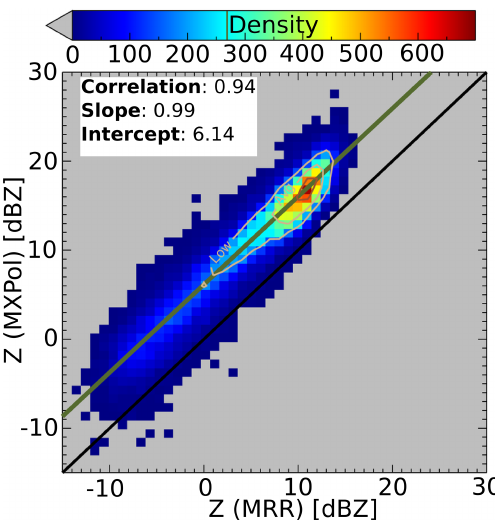
Figure 4. Scatter plot of reflectivity values at 9.41GHz (X-band, measured by MXPol) and at 24.3GHz (K-band, measured by the MRR) during the summer campaign 2015/2016. The data corre- spond to time steps at which both radar were profiling (PPI and RHI scans of MXPol do not contribute). Table 2. Parameters of the six X-band conversion relations between radar reflectivity Z and snowfall intensity S (mmh − 1 ] of Matrosov et al., 2009, and the local relation, obtained using the instruments at DDU. In these relations, the radar reflectivity ( Z ) must be used in linear units [mm 6 m − 3 ]. The six X-band relations originate from two different data sets (B90, ground-based, and W08, from in situ aircraft measurements), and three different mass to diameter rela- tions, as detailed in Matrosov et al.